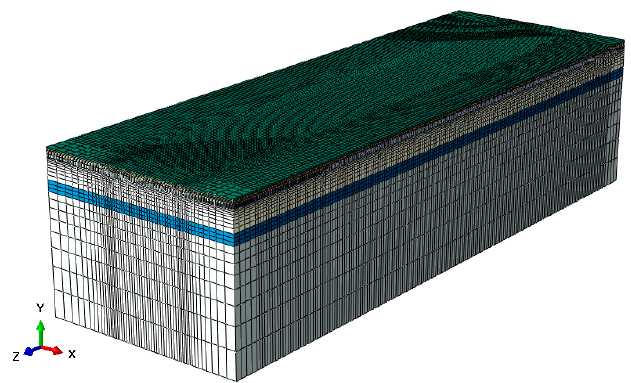
Figure 6. Pavement model meshed.